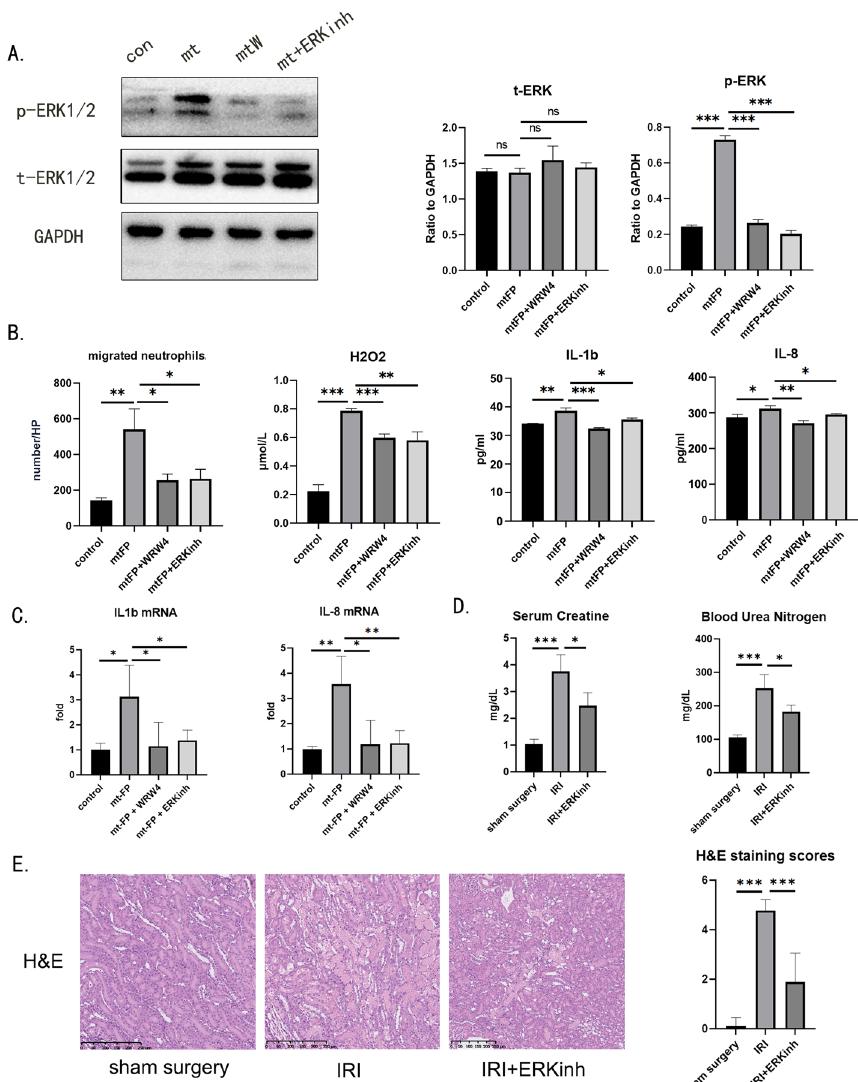
Fig. 6 The ERK1/2 pathway mediates mtFP–FPR2 axis-activated neutrophil proinflammatory functions. Primary neutrophils were purified from rat femur or tibia bone marrow using gradient centrifugation and cultured in pure RPMI 1640 medium. All in vitro experiments were conducted within 24 h after rat sacrifice. A Neutrophils were cocultured with mtFP, mtFP WRW 4 , or mtFP SCH772984. After 2 h of coculture, + + the expression levels of p-ERK1/2, t-ERK1/2, and GAPDH in neutrophils were determined by western blot analysis. B Neutrophils were plated in the top chamber (pore size, 3 μm) of a transwell system. Synthesized mitochondrial peptide mtFP were added to the bottom chambers, and the FPR2 inhibitor WRW 4 or the ERK1/2 pathway inhibitor SCH772984 was added to the top chambers. Two hours after top chamber insertion, migrated cells in the bottom chambers were counted. To measure H 2 O 2 levels in cell culture medium, neutrophils were cocultured with mtFP, mtFP WRW 4 , or mtFP SCH772984. After 2 h of coculture, + + the H 2 O 2 concentration in the neutrophil culture medium supernatant was measured by the Fenton reaction method. C Meanwhile, the levels of IL-1β and IL-8 in the supernatant were determined by enzyme-linked immunosorbent assays. D , E Serum from sham surgery, IRI, and SCH772984-treated rats was sampled at 24 h after surgery. Serum creatinine and blood urea nitrogen levels were measured. Kidney tissues were sectioned for histological examination. Scale bar, 100 μm. * P < 0.05, ** P < 0.01, *** P < 0.001. ns, P >